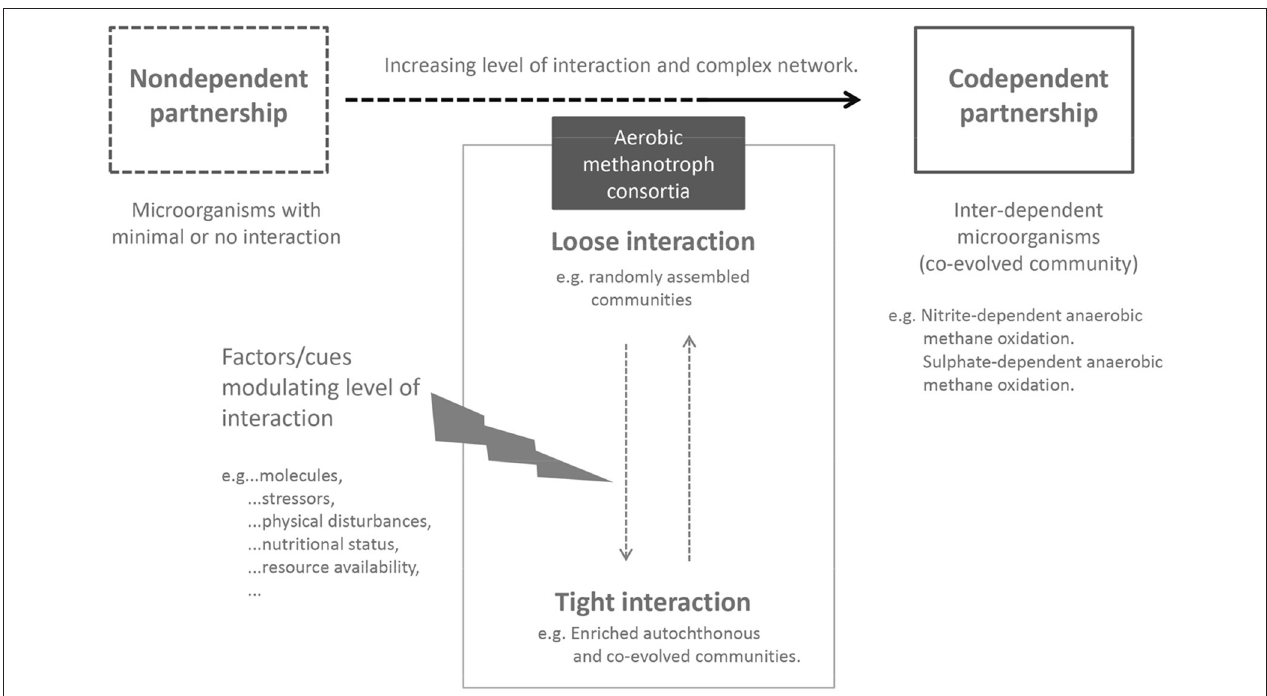
FIGURE 2 | Biotic interaction as modulator of methane oxidation. Obligate aerobic MOB forms a close-knit community with its biotic component, benefiting from interaction with other microorganisms in the consortium. Yet, aerobic MOB are not dependent on the interacting microorganisms as depicted by a co-dependent partnership. Within the MOB consortia, the level of interaction may oscillate depending on environmental conditions and factors/cues affecting the community